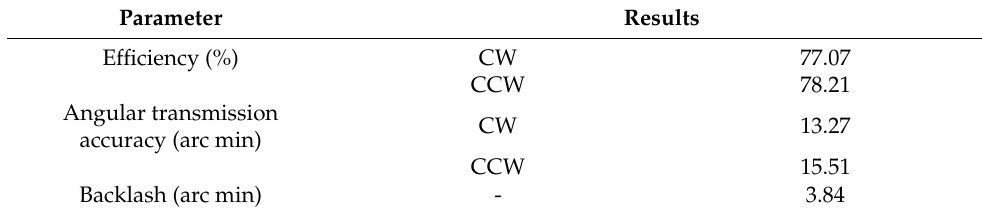
Table 3. Performance test results of cycloidal